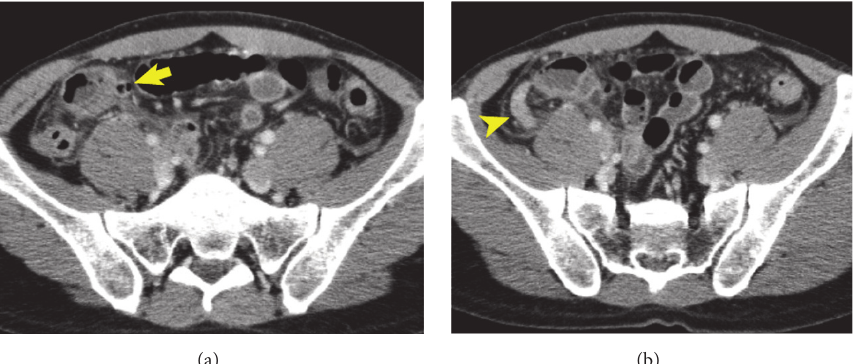
Figure 2: Computed tomography revealed diverticula in the terminal ileum (arrow) and swollen appendix with 10 mm in the diameter (arrow